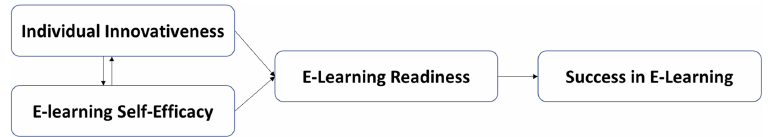
Figure 1. The path diagram of the relationship between individual innovativeness, self- efficacy and